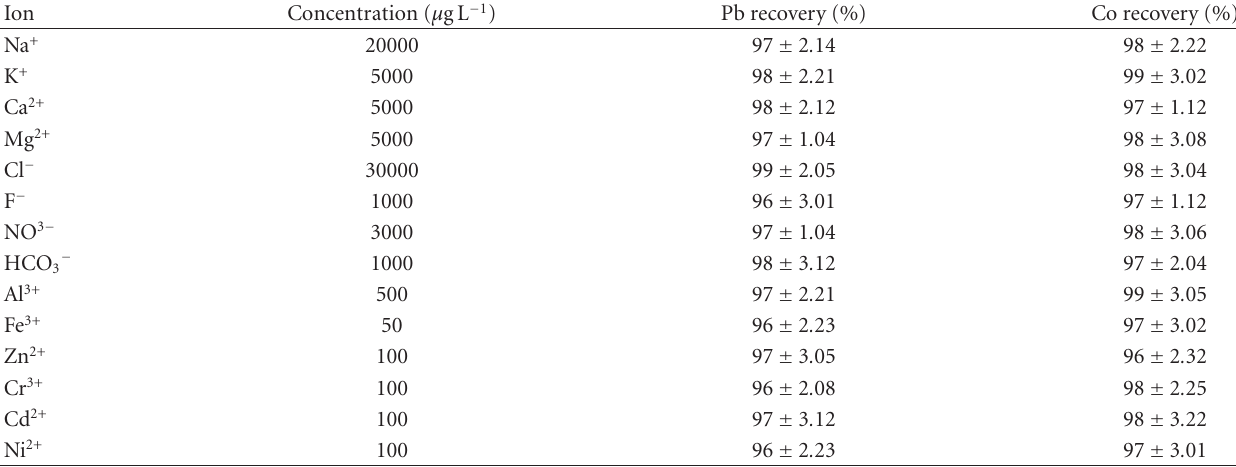
Table 1: Influences of some foreign ions on the recoveries of cobalt and lead (20 µ gL − 1 ) determination by applied CPE method.